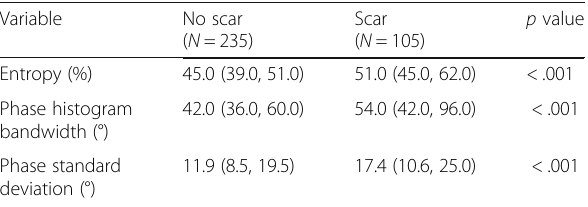
Table 2 Derivation cohort — association between scar and phase analysis, univariable analysis